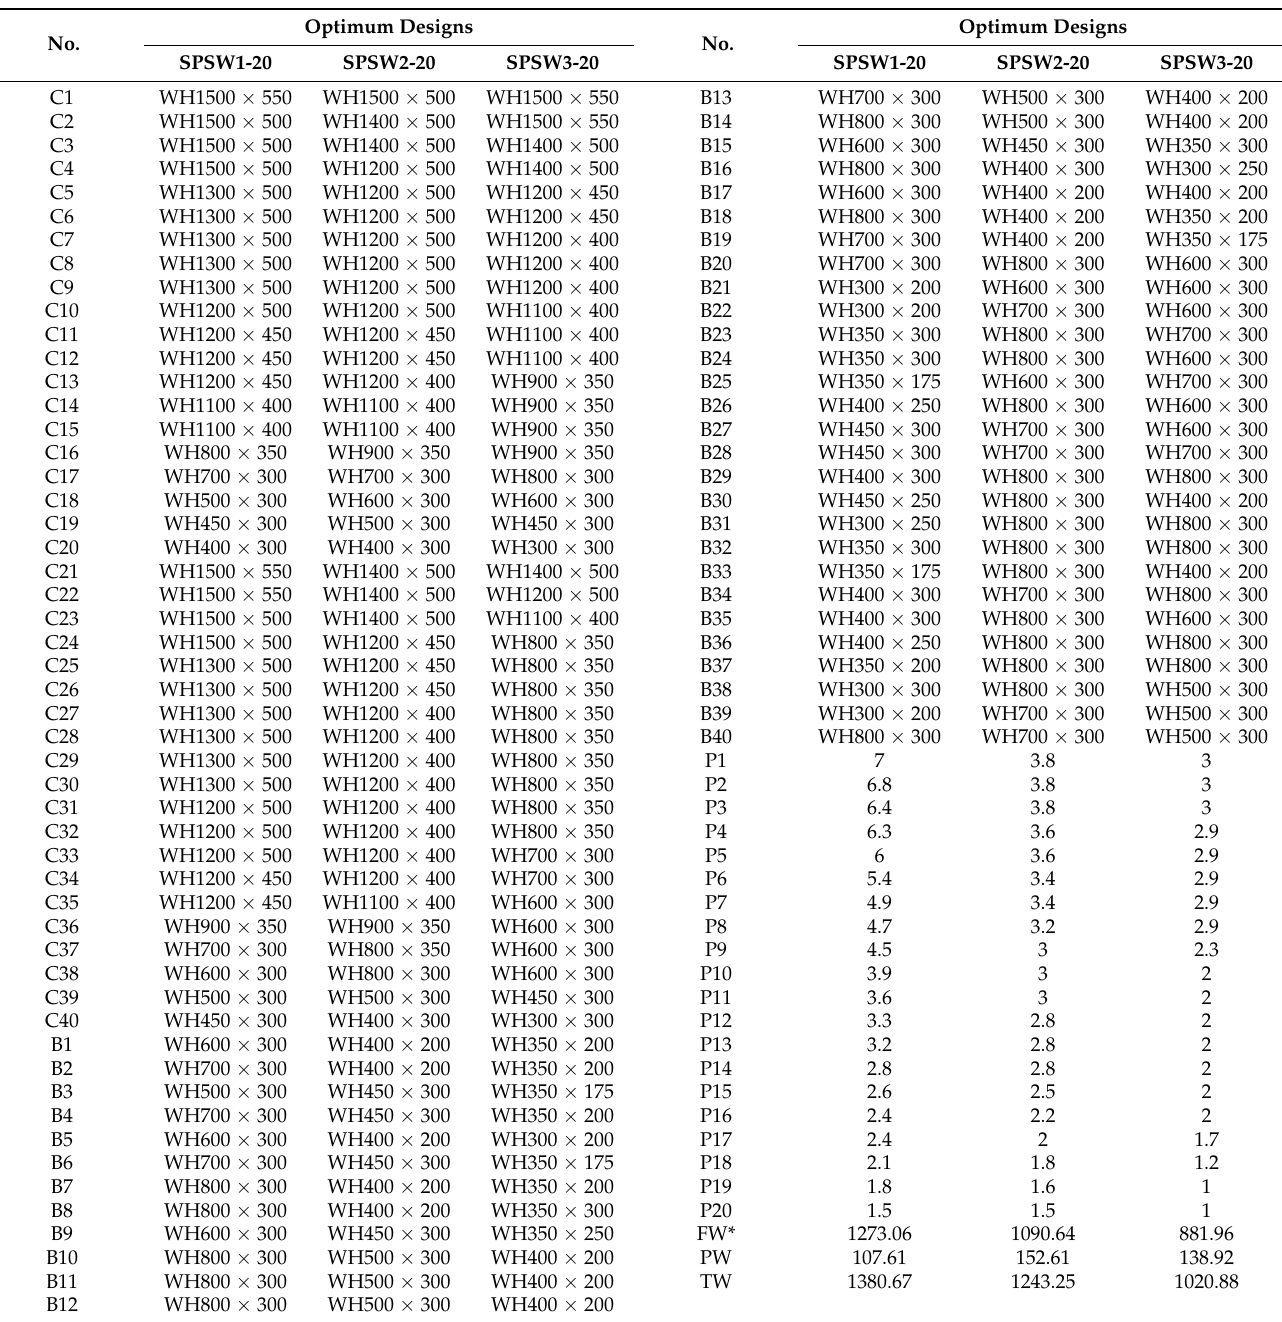
Table 11. Optimum designs of a 20-story steel